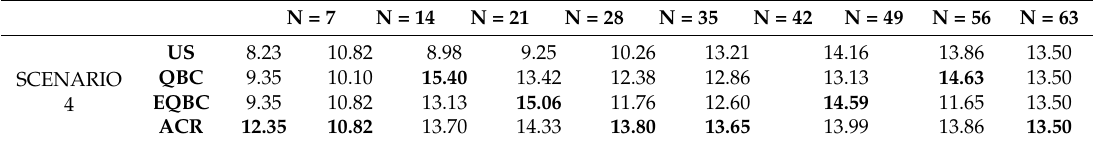
Table 8. LEI (RBFNN) in Scenario 4